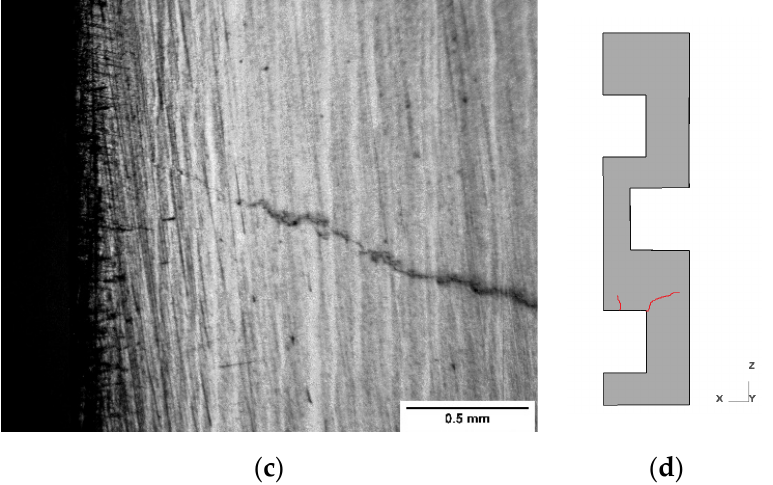
Figure 17. Developed cracks during water quenching: ( a ) V-WQ sample crack; ( b ) location of V-WQ crack; ( c ) H-WQ sample crack; and ( d ) location of H-WQ crack.